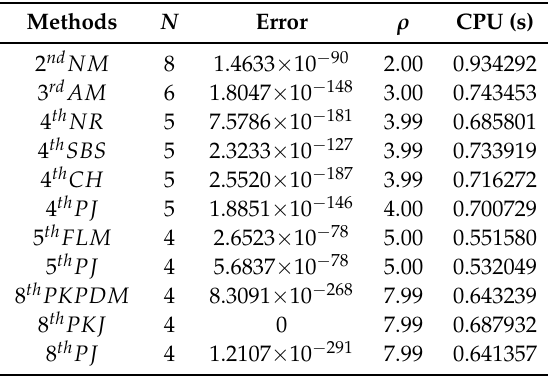
Table 10. Comparison of results for Application